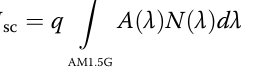
ffiffiffiffiffiffiffiffiffiffiffiffiffiffiffiffiffiffiffiffiffiffiffiffiffiffiffiffiffiffiffiffiffi ffiffiffiffiffiffiffiffiffiffiffiffiffiffiffiffi p A 2 þ B 2